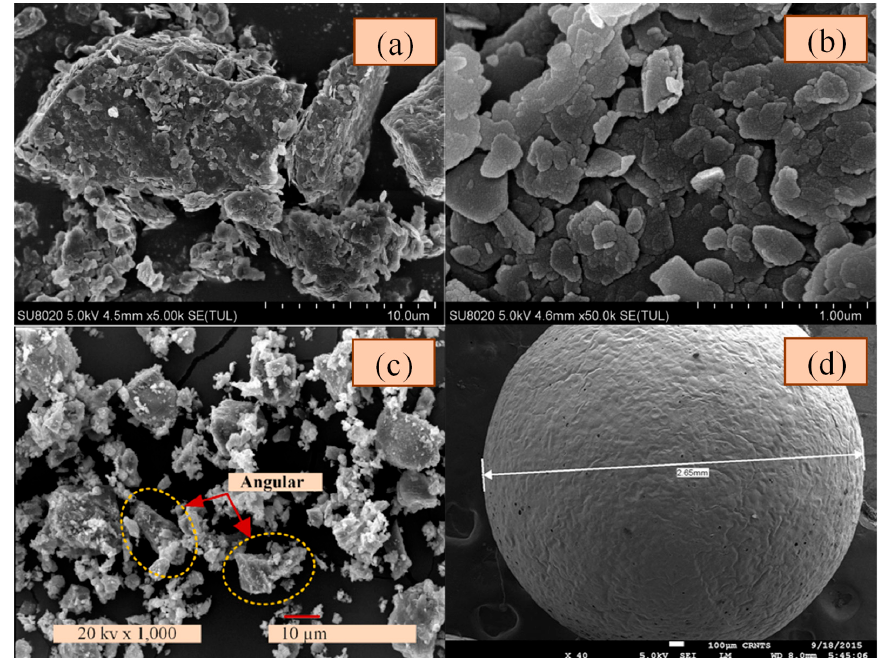
Figure 3. SEM images of four components: ( a ) Large particles of Singapore marine clay [49]; ( b ) small particles of Singapore marine clay [49]; ( c ) ordinary Portland cement (OPC) particles [2] and ( d ) an EPS bead [40].